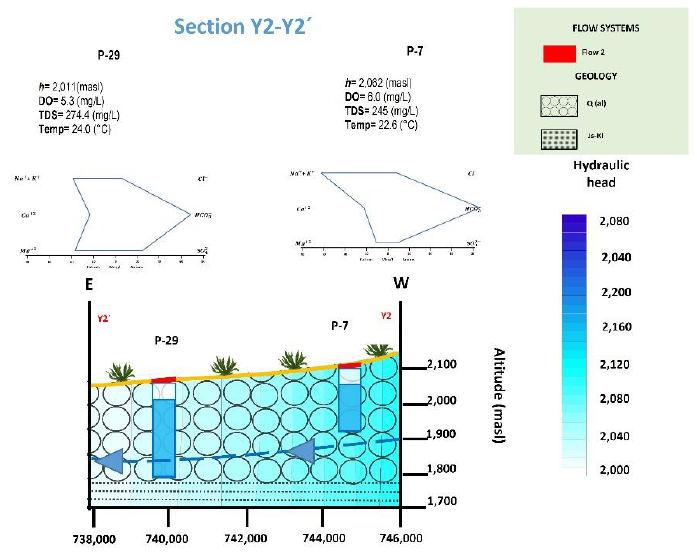
Figure 9. Hydrogeological cross section Y2 –Y2′.